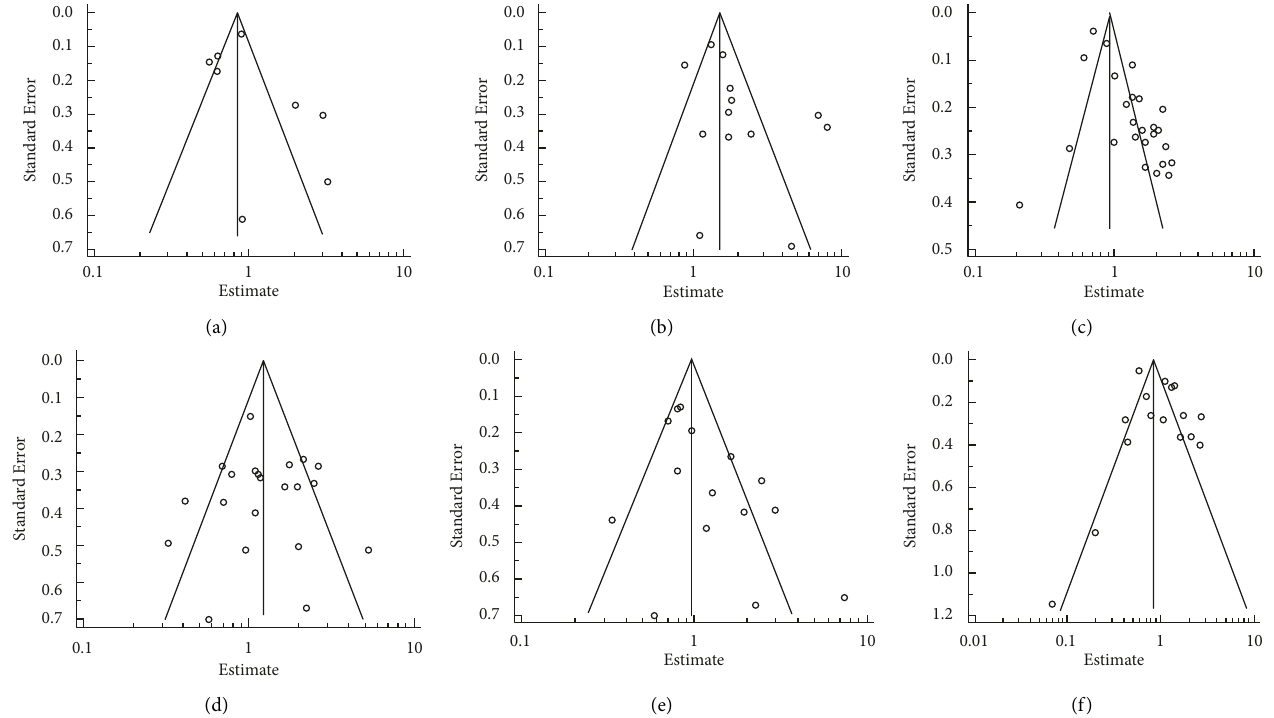
Figure 8: The funnel plot of studies included for APC gene and OS in CRC (a). The funnel plot of studies included for SMAD gene and OS in CRC (b). The funnel plot of studies included for β -catenin gene and OS in CRC (c). The funnel plot of studies included for β -catenin gene and DFS in CRC (d). The funnel plot of studies included for TP53 gene and OS in CRC (e). The funnel plot of studies included for TP53 gene and DFS in CRC